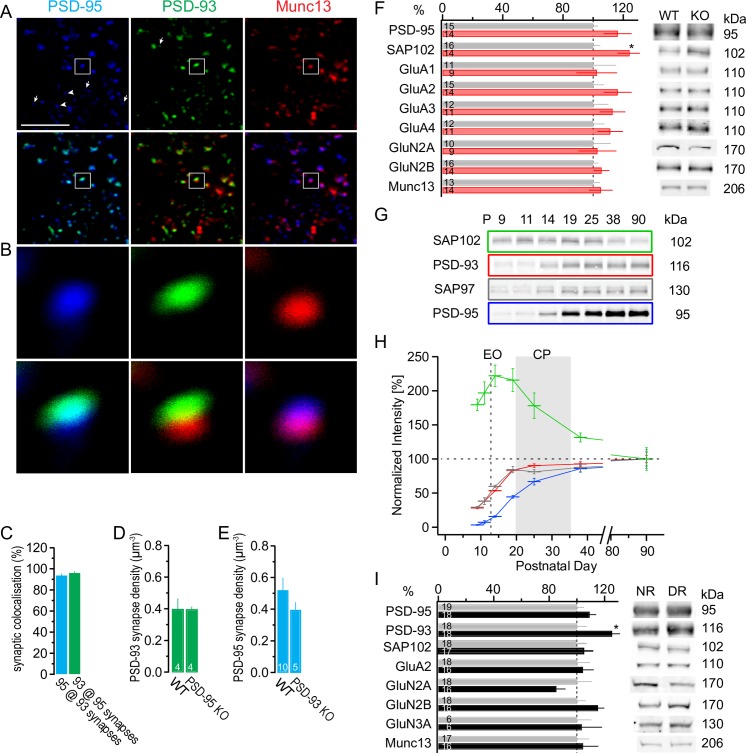
Synaptic and developmental profile of PSD-93 and PSD-95.(A, B) Immunofluorescence labeling of semi-thin sections with overview (A) and enlargement of boxed area (B) of mouse (P40) visual cortex for PSD-95 (blue), PSD-93 (green), and Munc13-1 (red). Upper panels illustrate fluorescence for single channels and lower panels for two channels, with PSD-95/PSD-93 (left), PSD-93/Munc13-1 (middle), and PSD-95/Munc13-1 (right). White arrowheads depict puncta with only one paralog colocalized with Munc13-1, and white arrows depict puncta of paralogs not colocalized with Munc13-1. Scale bar: 5 μm. (C-E) Quantification of synaptic colocalization (C) of PSD-95 in PSD-93/Munc13-1 positive puncta (blue) and of PSD-93 in PSD-95/Munc13-1 positive puncta (green). Synapse density, defined as puncta with PSD-93/Munc13-1 colocalization (D) in WT and PSD-95 KO mice. Similarly defined PSD-95 synapse density in WT and PSD-93 KO mice. Number of animals in foot of bar. See also S5 Fig. Underlying data for this figure can be found in S1 Data. (F) Protein levels in crude synaptosomes of the visual cortex in P28 WT (gray) or PSD-93 KO mice (red). Values of samples from each mouse were normalized to the average value of WT mice for each indicated protein on a western blot and presented as the relative amount compared with the WT band intensity. Sample bands for each protein and genotype are illustrated on the right. t test, *p < 0.05. (G-H) Developmental profile of synaptic proteins PSD-95 (blue), PSD-93 (red), SAP97 (gray), and SAP102 (green) from crude synaptosomal fractions from V1 of WT mice. Sample blots (G) are illustrated for the indicated proteins, and quantified protein levels, normalized to the adult levels at P90, are plotted against the postnatal day (P, H). n = 4–5 (mice). Values for PSD-95 are from a previous report [8]. Underlying data for this figure can be found in S1 Data. (I) Comparison of synaptic protein levels from crude synaptosomal fractions from DR (black) and NR (light gray) mice at P28. Protein levels were assessed as described in panel F. Number of mice is indicated in the foot of the bar. t test, *p < 0.05. Underlying data for this figure can be found in S1 Data. CP, critical period; DR, dark-reared; EO, eye opening; Glu, glutamate receptor subunit; KO, knock-out; Munc13-1, Mammalian uncoordinated 13–1; NR, normal-reared; P, postnatal day; PSD, postsynaptic density; SAP, synapse-associated protein; V1, primary visual cortex; WT, wild-type.